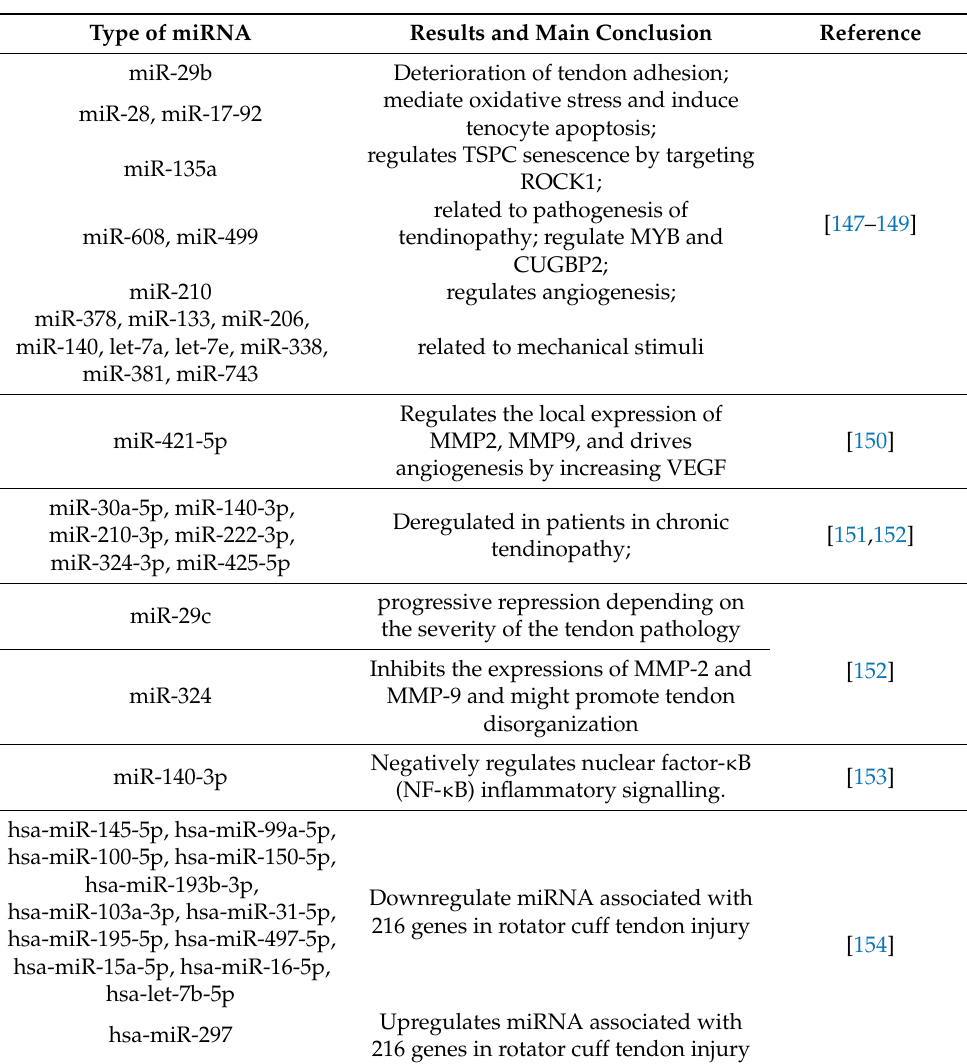
Table 2. miRNAs featured in tendons and bone